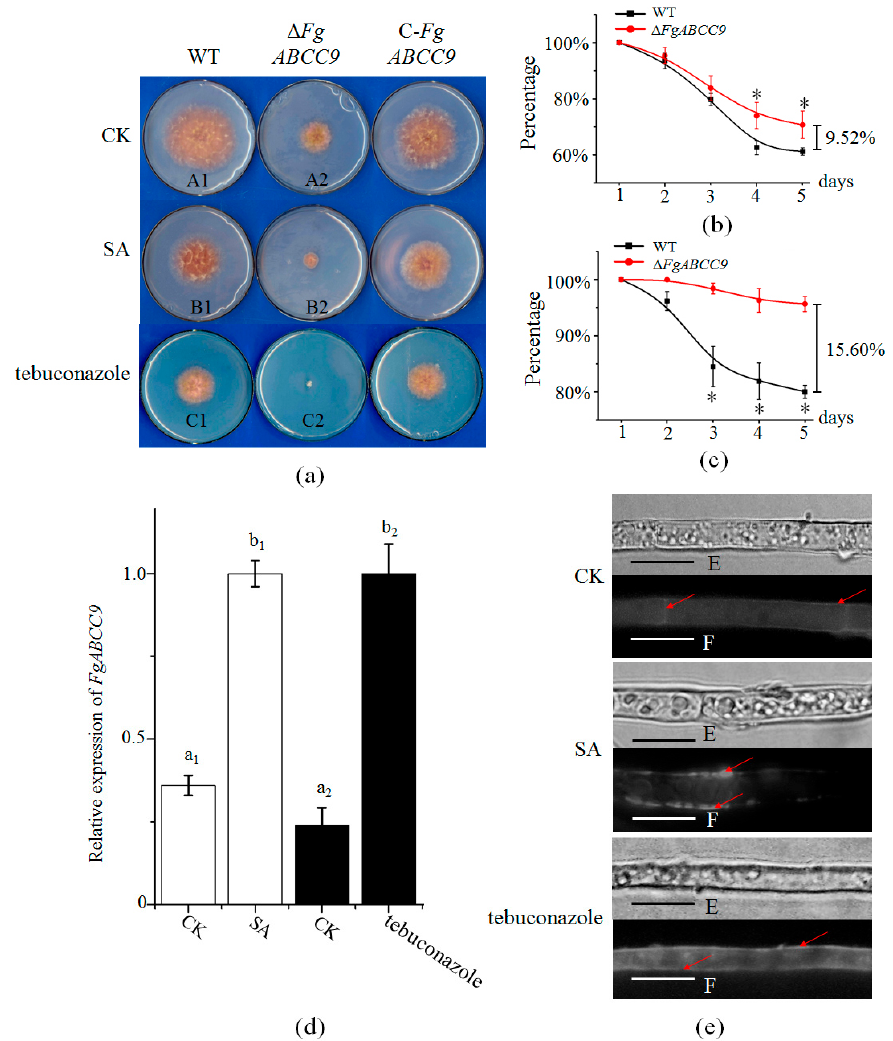
Figure 2. Effect of FgABCC9 on mycelial growth. ( a ) Mycelial growth on mSNA (modified Synthetischer Nährstoffarmer Agar) plates with SA and tebuconazole. CK, control treatment. Plates were photographed on the fourth day post inoculation. ( b ) Percentage of mycelial growth inhibited by SA ([A1-B1]/A1 for WT, [A2-B2]/A2 for Δ FgABCC9 ). ( c ) Percentage of mycelial growth inhibited by tebuconazole ([A1-C1]/A1 for WT, [A2-C2]/A2 for Δ FgABCC9 ). Asterisks represent significance at p < 0.05. A1, B1, and C1 indicate mycelial areas of WT strain under the CK, SA, and tebuconazole treatments, respectively. A2, B2, and C2 indicate mycelial areas of Δ FgABCC9 under the CK, SA, and tebuconazole treatments, respectively. The experiments were repeated three times with 10 plates for each treatment. ( d ) Expression changes of FgABCC9 under SA and tebuconazole treatments in the WT strain. Different letters above each column indicate significance at p < 0.05. ( e ) Subcellular localization of the FgABCC9 protein. The fluorescent signal is marked with red arrows. E, Optical microscope. F, fluorescence microscope. Scale bar, 10 µ